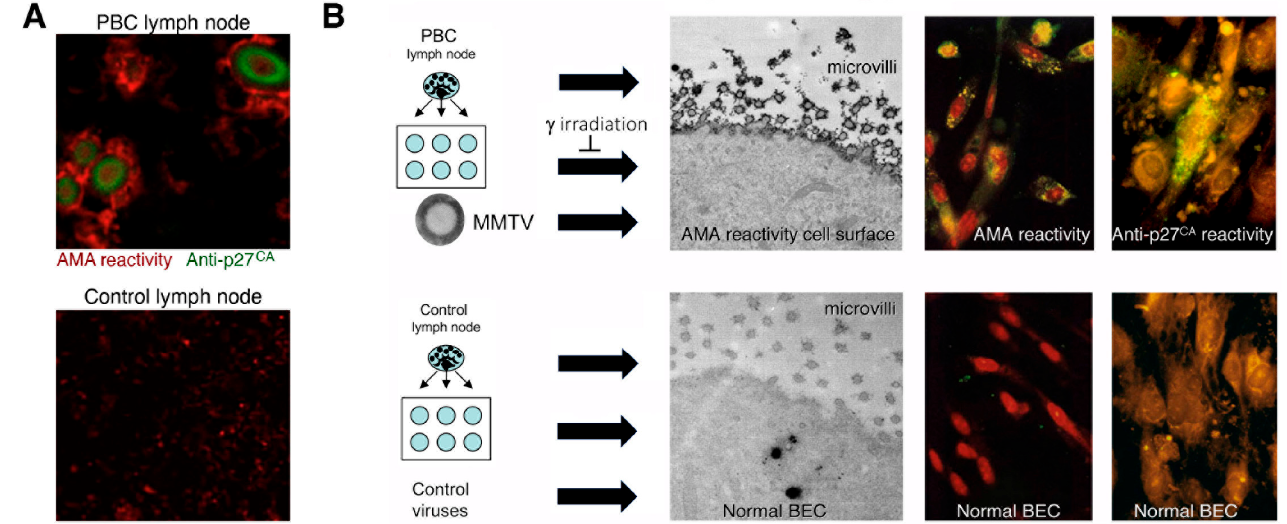
Figure 2. ( A ) Perihepatic lymph nodes from patients with PBC are infected with HBRV and have evidence of HBRV anti-p27 Capsid reactivity (green label) is detected in cells that express aberrant AMA reactivity (red label), whereas the control lymph node only shows AMA reactivity in mitochondria and no evidence of HBRV infection. ( B ) Co-cultivation studies show that biliary epithelial cells (BEC) develop mitochondrial autoantigen expression with AMA reactivity when incubated with (i) PBC patient’s lymph node homogenates, (ii) conditioned supernatants, and (iii) MMTV. Perihepatic lymph nodes from PBC and control patients were homogenized and co-cultured with normal BEC isolated from liver transplant recipients. Subsequently, the PBC lymph node-conditioned BEC demonstrated AMA reactivity as observed by immunoelectron microscopy and evidence of HBRV anti-p27 Capsid proteins by immunofluorescence. Conditioned supernatants had the same effect, whereby only the PBC-conditioned supernatants triggered AMA reactivity. This process was abrogated by γ -irradiation. Normal BEC incubated with supernatant from MMTV-producing MM5MT cells also showed AMA reactivity and anti-p27 Capsid immunofluorescence, whereas control viruses had no such effect. Copyright 2003 National Academy of Sciences.